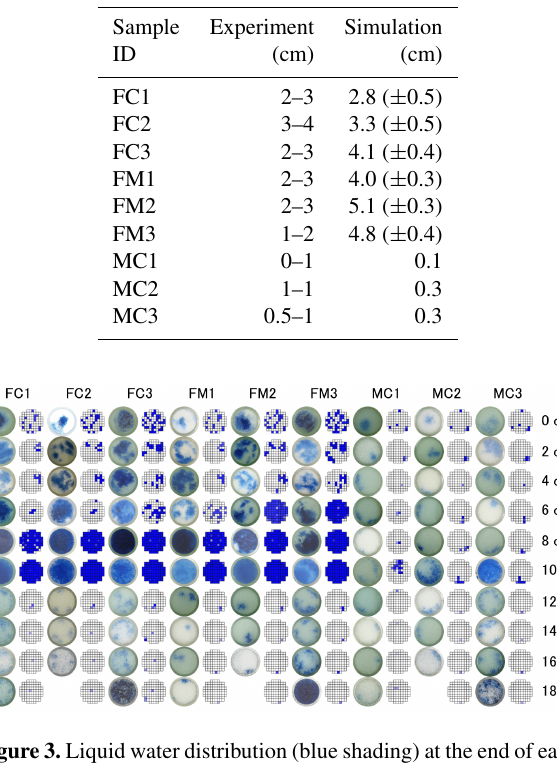
peaked at the interface between layers, and decreased in the lower